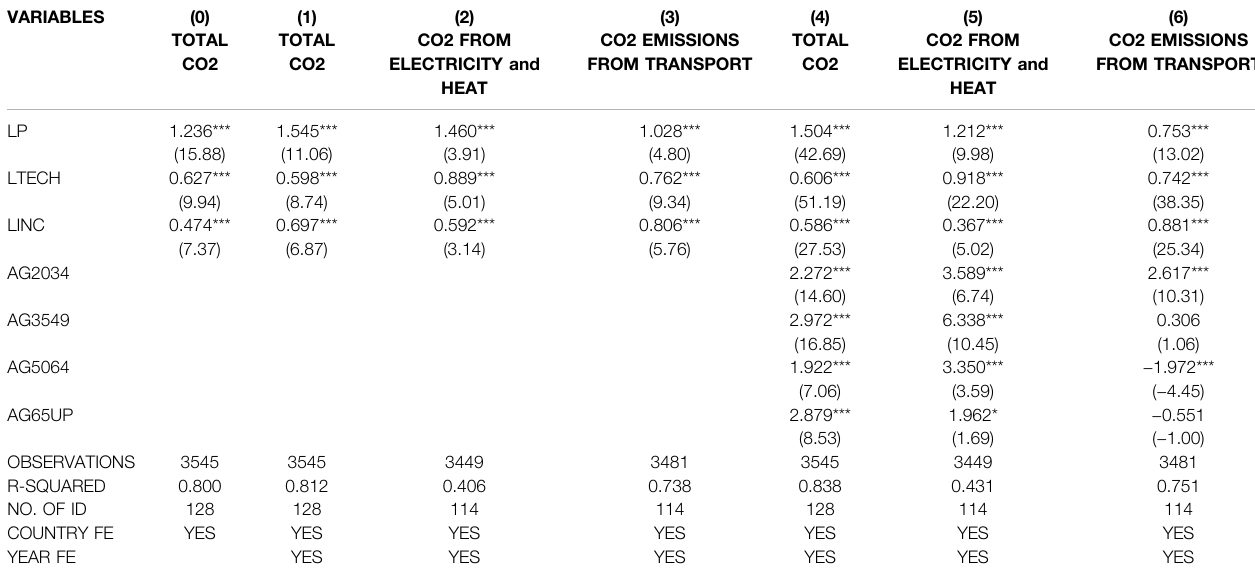
TABLE 3 | Basic results of age structure and carbon emission